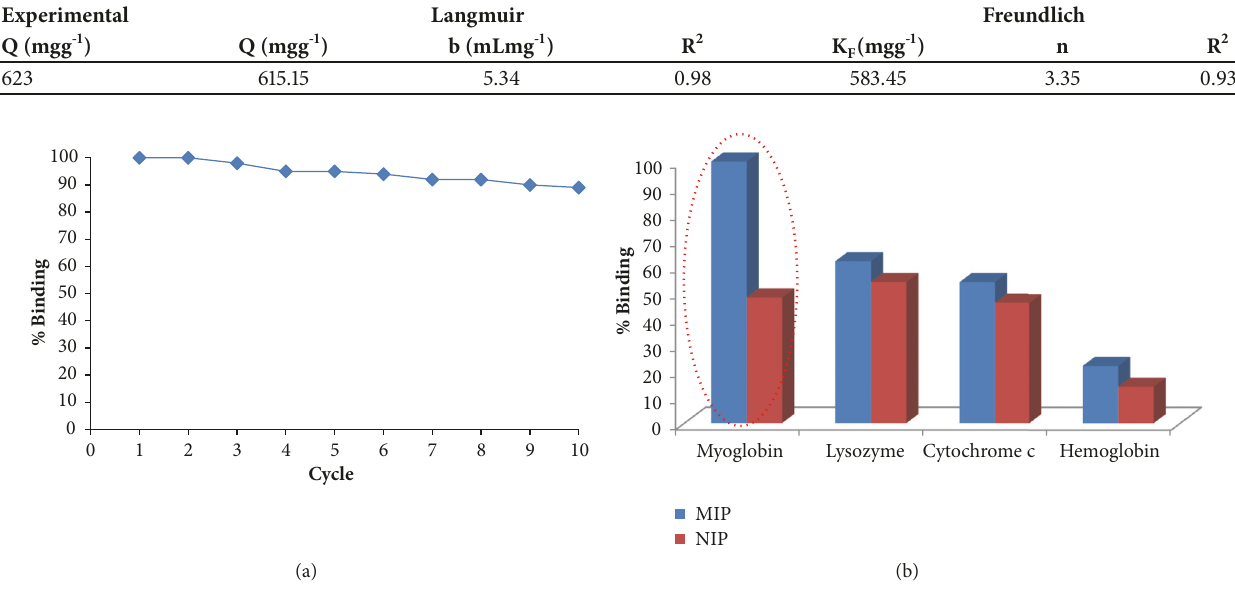
Figure 6: (a) Reusability of the myoglobin imprinted microbeads [C Mb : 0,5 mgmL −1 , m microbeads : 20mg, pH: 7.0, t: 1h, T: 25 ∘ C]. (b) Selectivity of the MIPs and NIPs for myoglobin.